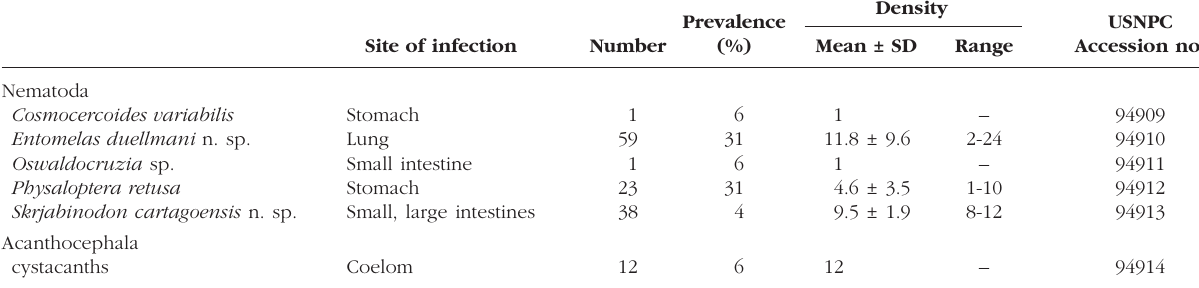
Table III. – Site of infection, number of individuals, prevalence, abundance, mean and range of infection for six species of helminths in Mesaspis monticola